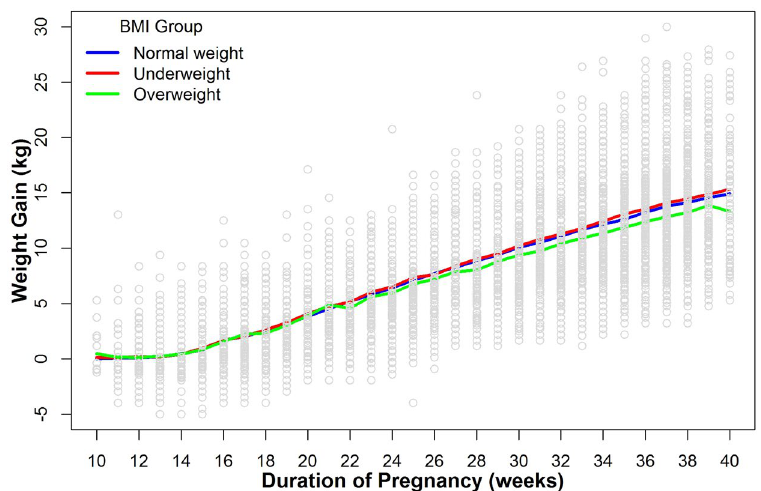
Figure 2. Line chart of mean GWG by gestational age according to the pre-pregnancy BMI categories. Blue line for pregnant women with pre-pregnancy normal weight, red line for pregnant women with pre-pregnancy underweight, and green line for pregnant women with pre-pregnancy